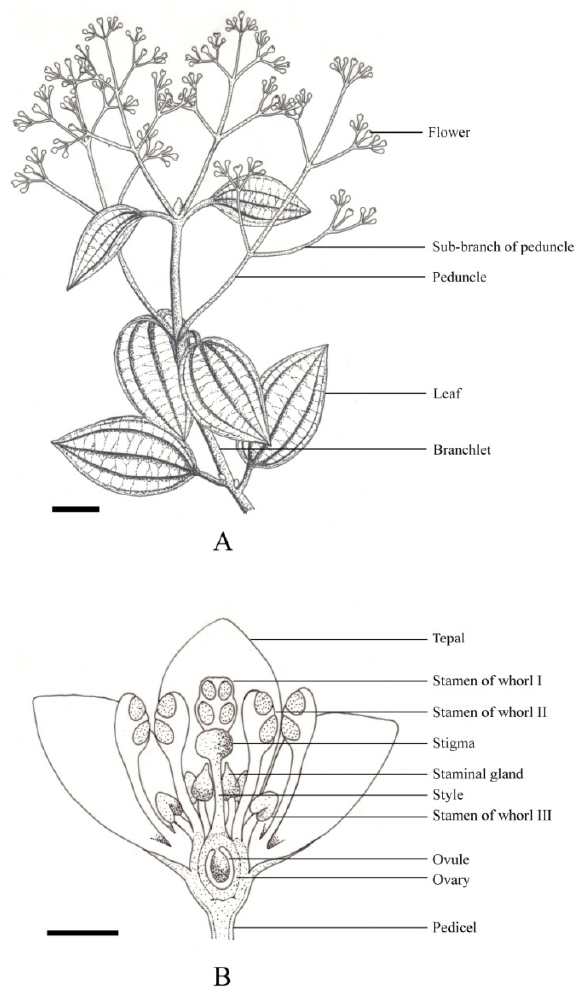
Figure 4: Floral abnormalities in Cinnamomum verum . 1A & 2A. Inflorescence, Scale bar = 2 cm; 1B & 2B. Longitudinal view of flowers, Scale bar = 5 mm and 1C & 2C. Front view of flowers, Scale bar = 5 mm